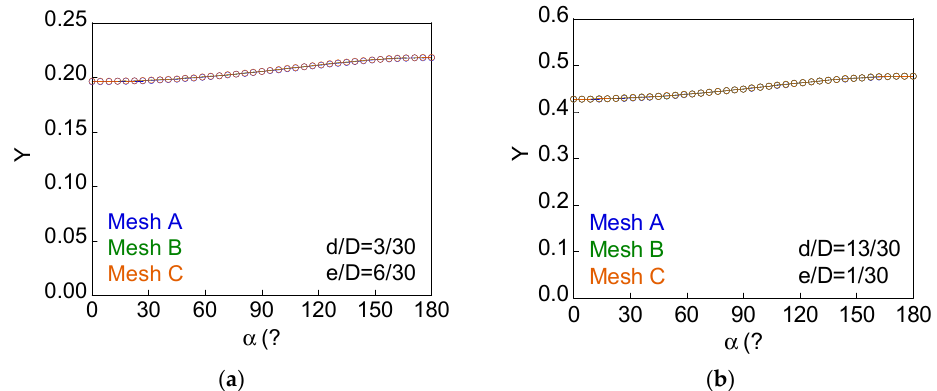
Figure 5. Dimensionless SIF along the crack front for c / b = 1 (convergence study of the mesh size): ( a ) d / D = 3/30 and e / D = 6/30; ( b ) d / D = 13/30 and e / D = 1/30.